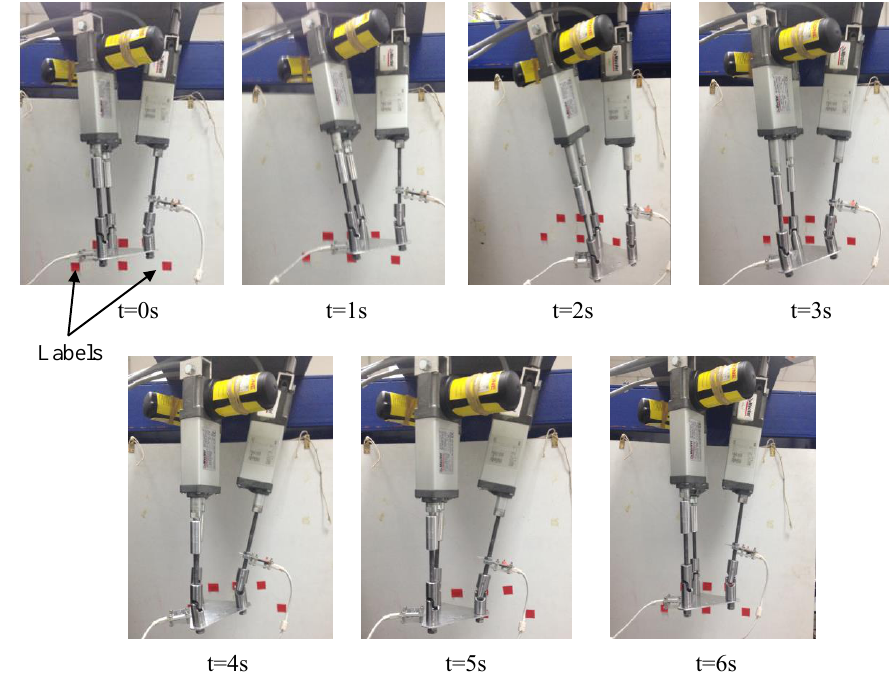
Figure 10. A sequence of snapshots of the prototype during a test following the prescribed motion for the